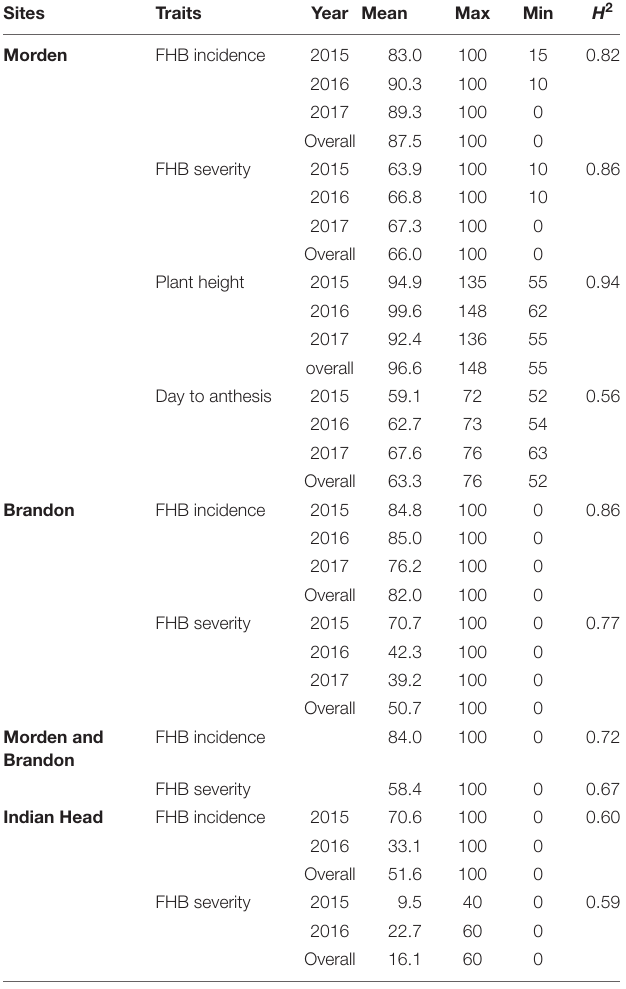
TABLE 1 | Mean, range and heritability of the durum association mapping panel (AM) for FHB incidence, FHB severity, plant height (cm), and days to anthesis (DTA) for the individual trial in Morden, Brandon, and Indian Head across the 2015–2017 trial series, and across sites between Modern and Brandon. Sites Traits Year Mean Max Min H